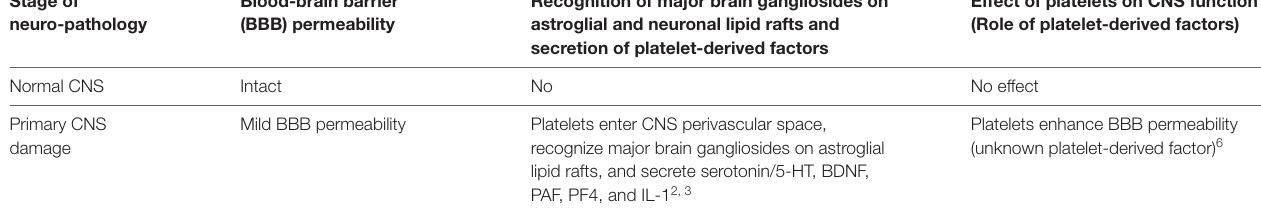
TABLE 1 | Platelet-neural crosstalk and possible mechanisms involved in the development of neurodegenerative diseases and central nervous system (CNS) repair 1 . Stage of